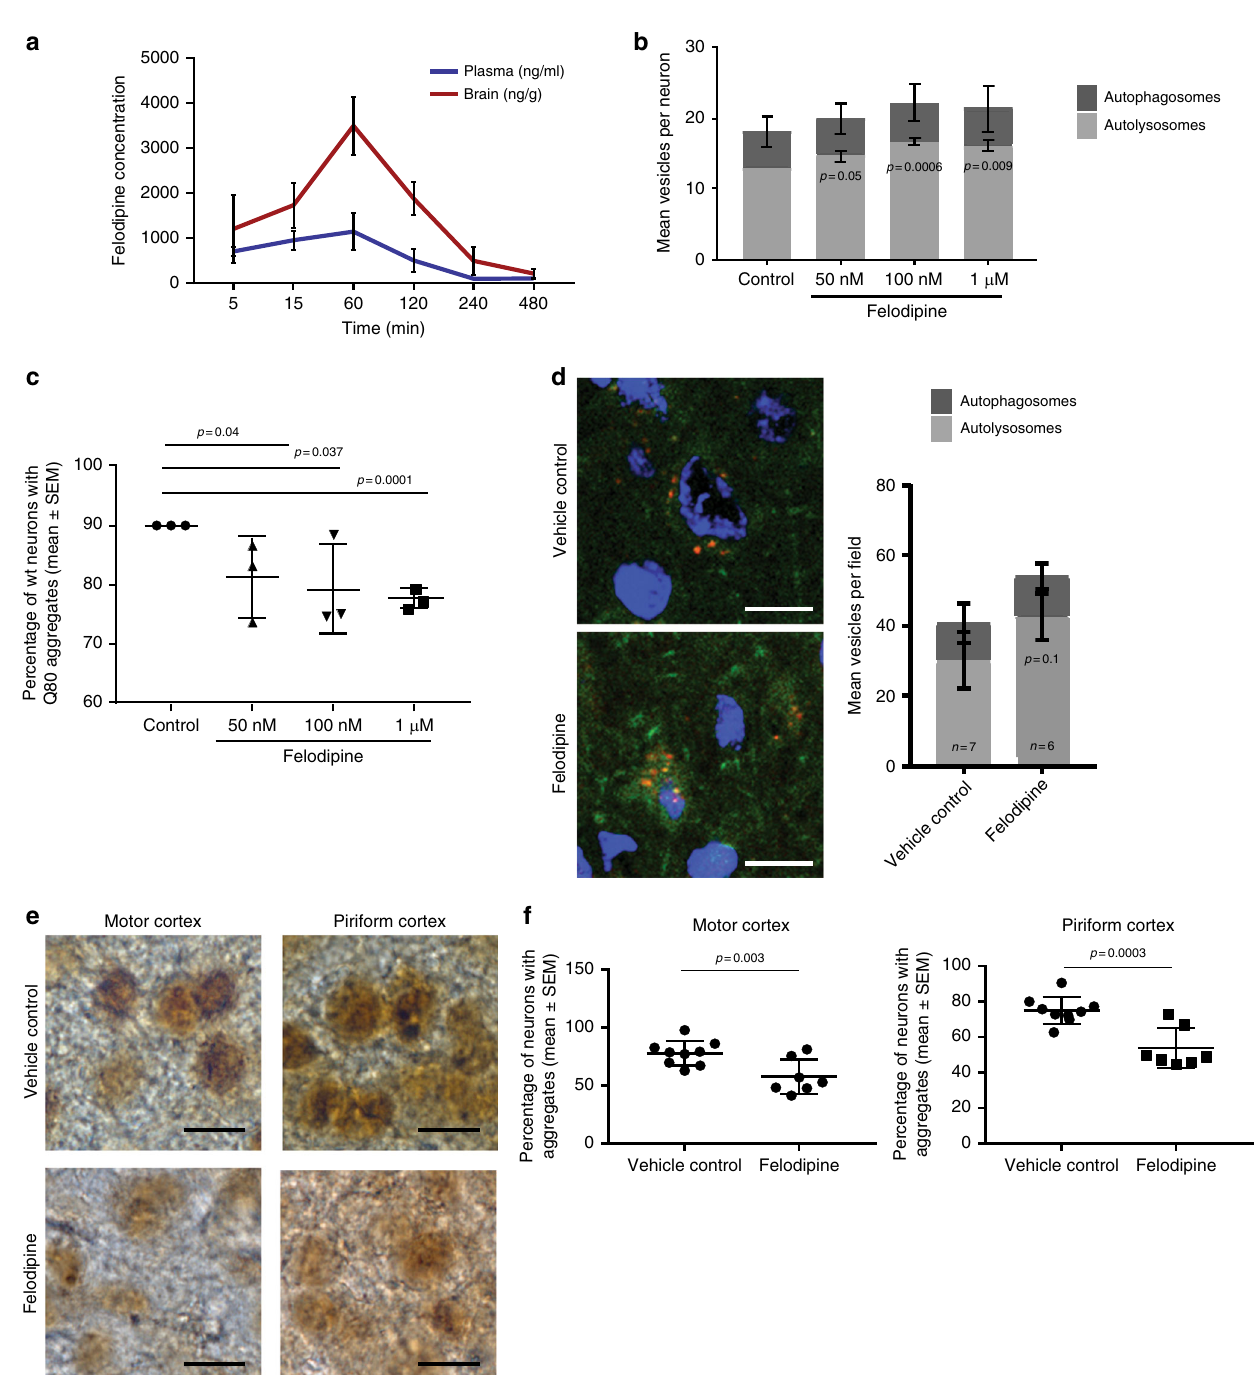
Fig. 4 Felodipine pharmacokinetics and bioavailability. a Plasma and brain felodipine concentrations at 0, 5, 10, 60, 120, 240, and 480 min after single i.p. injection of 5 mg/kg body weight of felodipine in C57Bl6 wild-type mice, n = 3 mice per time-point. Means + / − SEM. b Felodipine (50 nM, 100 nM and 1 μ M) in primary cortical neurons from mRFP-GFP-LC3 mice. Mean numbers of vesicles + / − SEM per neuron normalised to number of autolysosomes in DMSO (control); one sample, one-tailed unpaired t -test; exact p values for comparison of autolysosome numbers are shown. c Percentages of EGFP- positive neurons with aggregates (means + / − SEM ( n = 3 independent experiments)). Data normalised to DMSO control in each experiment, set at 90. One-tailed unpaired t -test. d – f Double transgenic mRFP-GFP-LC3/B6HD male mice were implanted with felodipine-loaded minipumps (5 mg/kg/day) with 0.25 μ l/h fl ow rate for 28 days. d Felodipine treatment increased the number of autolysosomes. Mean values + / − SEM; mean values for each vesicle type (autophagosomes, autolysosomes and total vesicles) for felodipine were compared with the same vesicle type of vehicle control, one-tailed unpaired t -test; exact p values are shown for autolysosomes. Only mice expressing detectable fl uorescence of the mRFP-GFP-LC3 transgene were included in the fi nal analysis. Representative images of cerebral cortex — scale bar = 10 µ m. e Representative images of huntingtin inclusions in motor and piriform cortices. Scale bar = 10 µ m. f Felodipine signi fi cantly reduced the percentage of cells with aggregates in both regions. Data are mean percentage of cells with aggregates per fi eld with + / − SEM, using one-tailed unpaired t -test; exact p values for felodipine vs. vehicle control for each region are